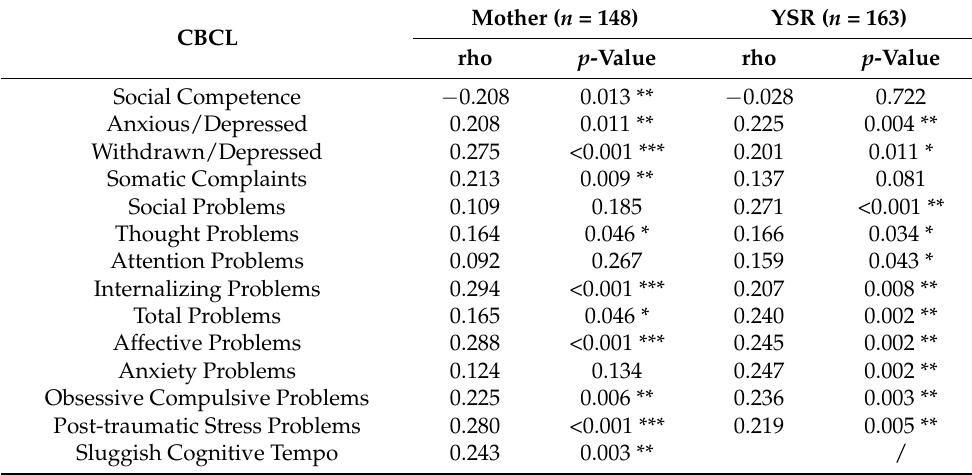
Table 3. Correlations between “length of stay” and CBCL-mother and YSR-patient scores. Mother ( n = 148) YSR ( n = 163) CBCL rho p -Value rho p -Value